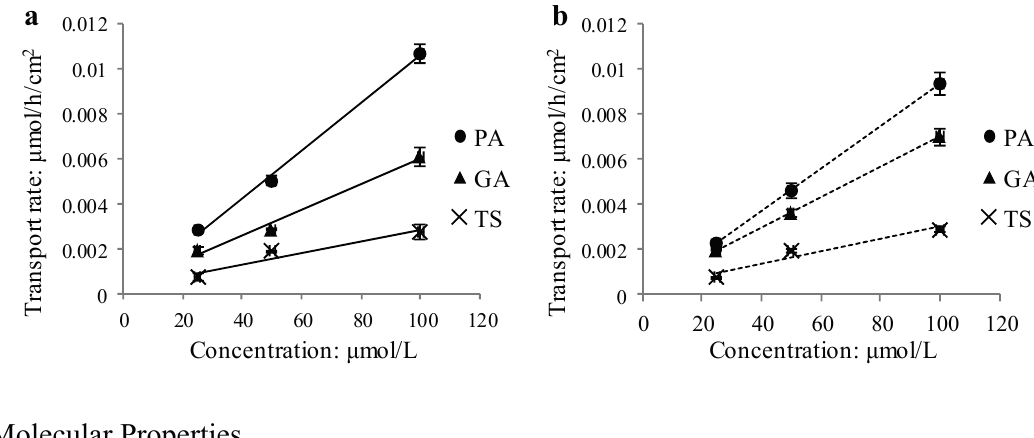
Figure 4. Transport of three phenolic acids across Caco-2 monolayer as the function of